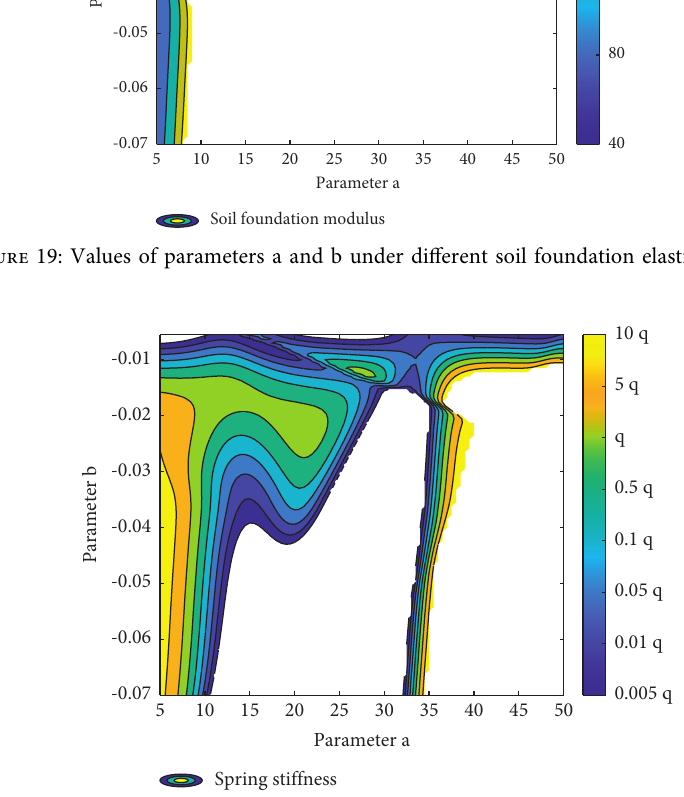
Figure 20: Values of parameters a and b under different spring